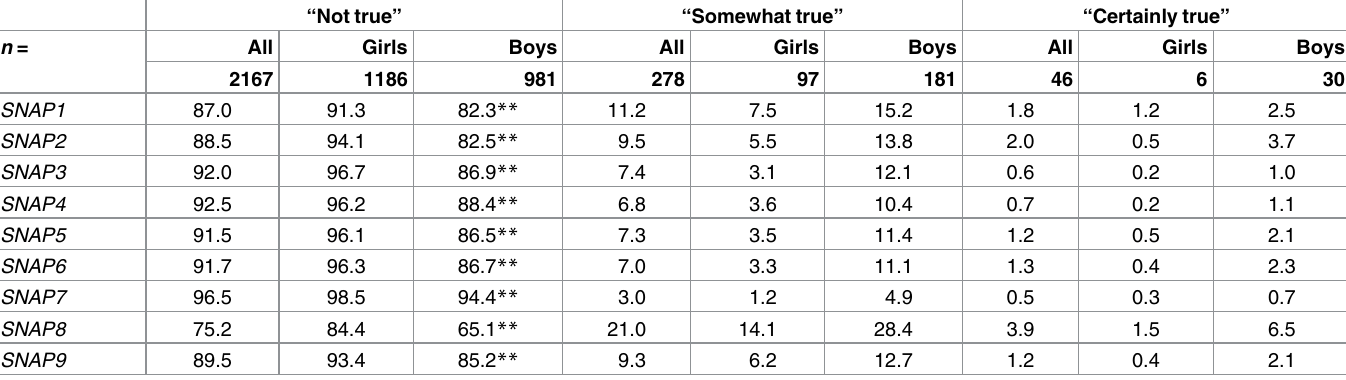
The data analysis was divided into three parts: ( a ) data preparation, including discretising the average academic achievement into three levels, ( b ) casting the data analysis problem into a machine learning classification task assessing feature importances using both a multinomial logistic regression (MLR), classification and regression trees (CART), and a random forest (RF) algorithm, and ( c ) a pattern classification procedure using k -fold cross-validation with Table 2. Percentage of children obtaining a given response from their teachers on each inattention item (SNAP-IV). “Not true” “Somewhat true” “Certainly true” n = All Girls Boys All Girls Girls